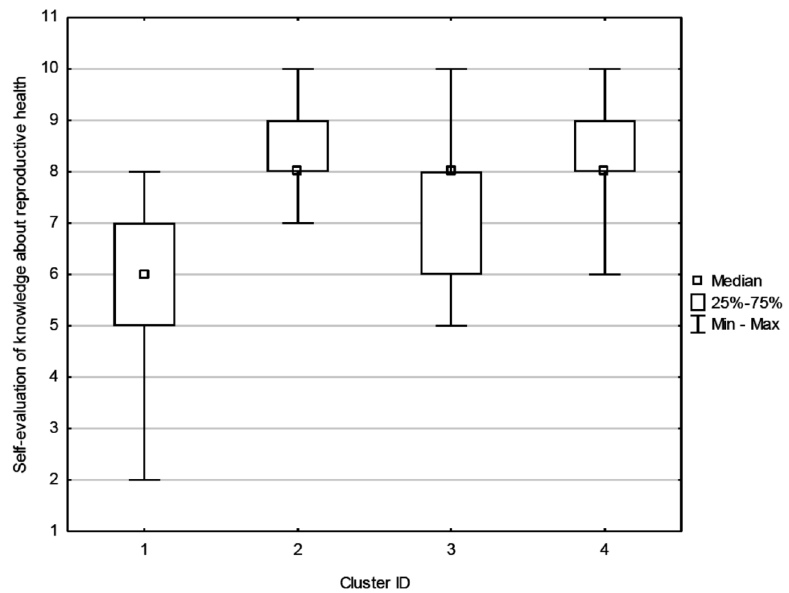
Figure 1. Level of declared knowledge about reproductive health for each